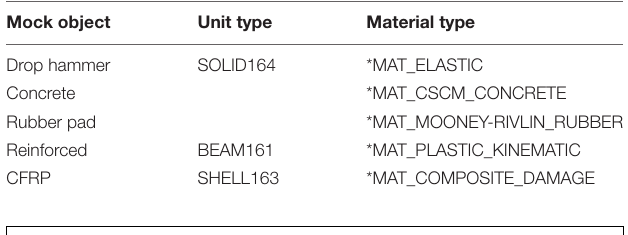
TABLE 2 | Unit and material type selection.